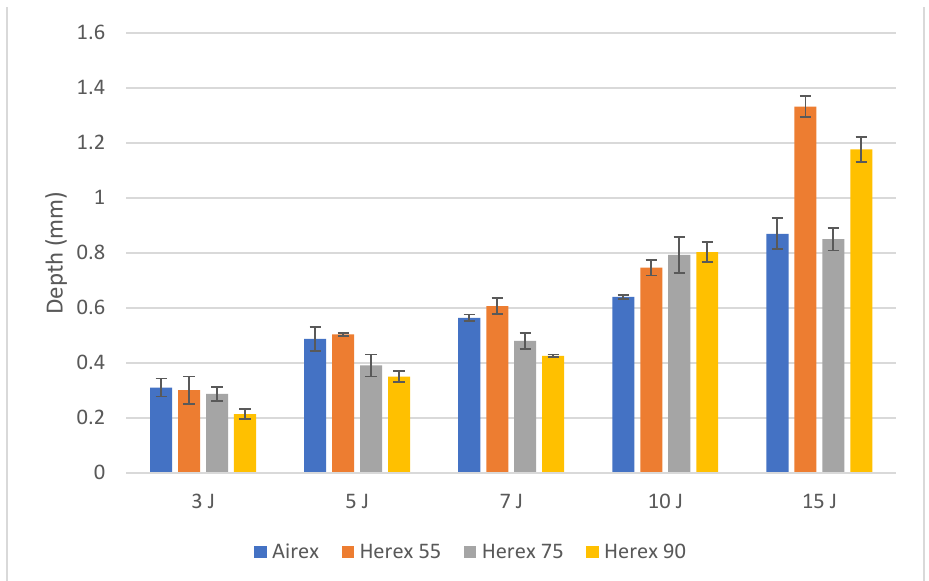
Figure 5. Measured depth of composite damage after concentrated dynamic loading.